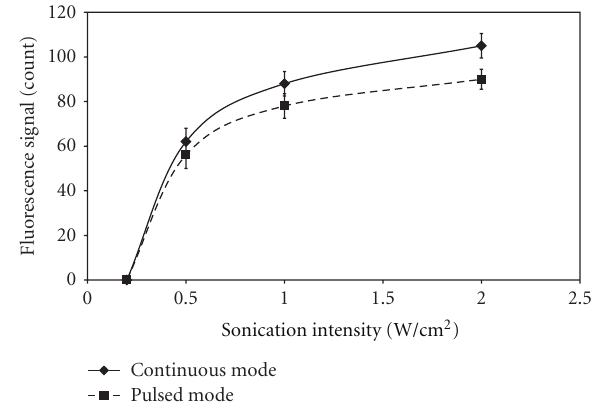
Figure 4: Recorded fluorescence signal intensity in the TA solutions in the absence and presence of GNPs at 0.5, 1, and 2 W/cm 2 intensities in pulsed mode (in duty cycle of 50%), excitation wavelength = 310nm, and emission and excitation band width = 5nm.